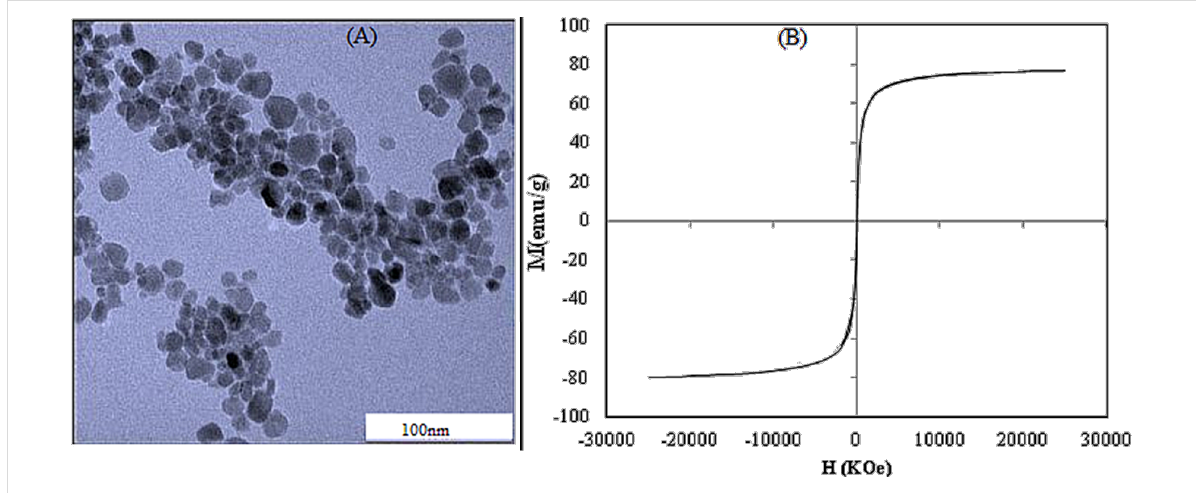
Figure 4: (a) TEM micrograph of the APTES–SPION (b) Magnetization curves of the APTES-functionalised SPION at 300 K.